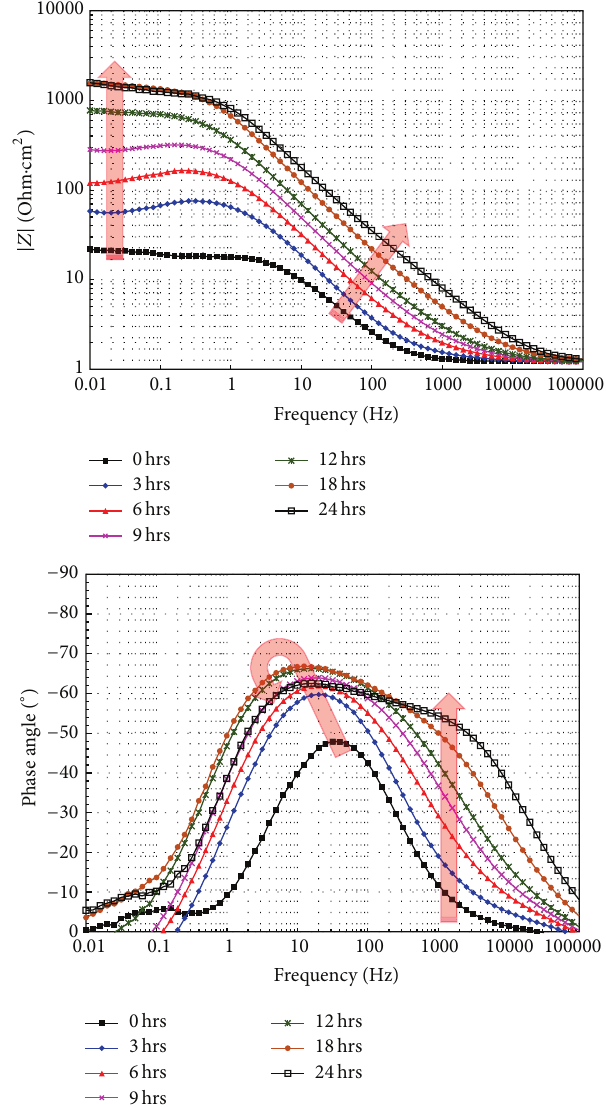
Figure 7: Nyquist and Bode plots for 1018 carbon steel in CO 2 - saturated (3% NaCl + 10% diesel) emulsion with 25 ppm of stearic amide at 50 ∘